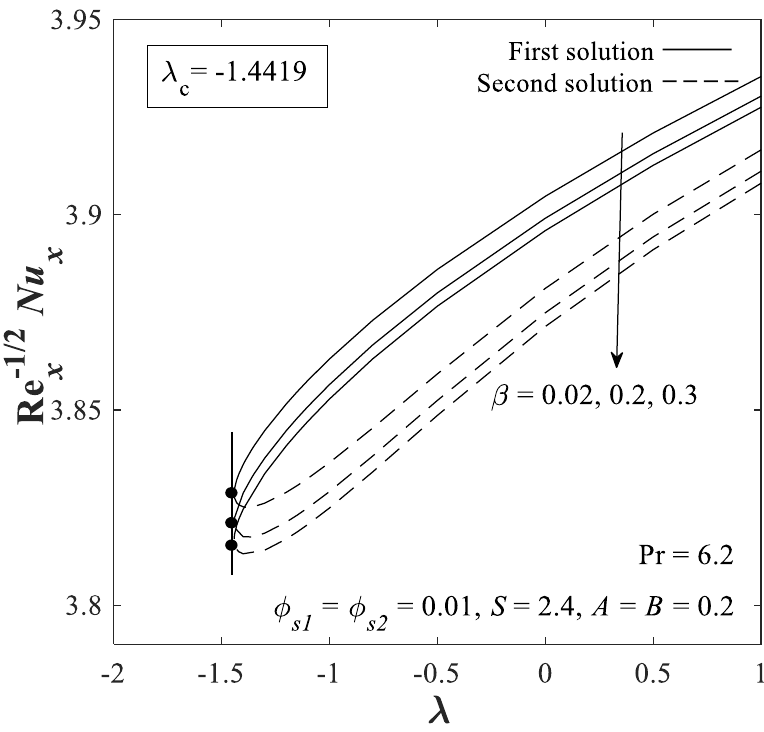
− 1/2 Nu with λ for varied β . Figure 5. Plot of Re x Nu x with λ for varied β . x x